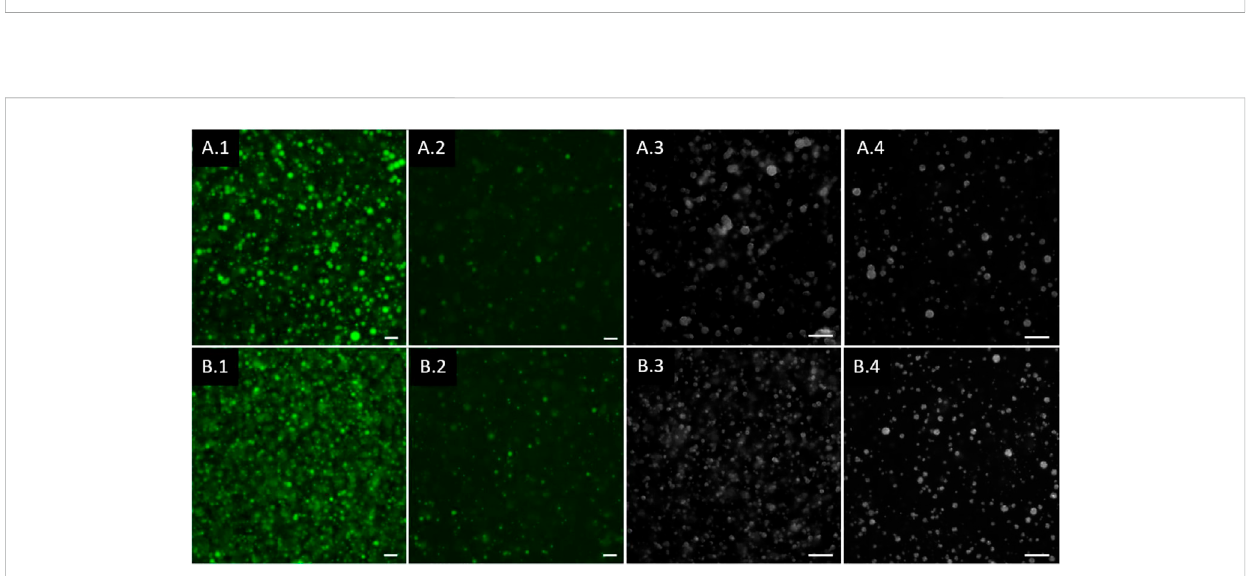
FIGURE 5 Epi fl uorescence ( A.1, A.2 and B.1, B.2 ) and dark fi eld ( A.3, A.4 and B.3, B.4 ) images using Dex-FITC within samples, in stable droplets prepared after solvent shifting ( A.1, A.3 and B.1, B.3 ) and after dilution ( A.2, A.4 and B.2, B.4 ), when mixed with TEOS ( A.1 – 4 ) and 1-Ethyl-3-carbodiimide (EdC) ( B.1 – 4 ). (Scale bars are for 20